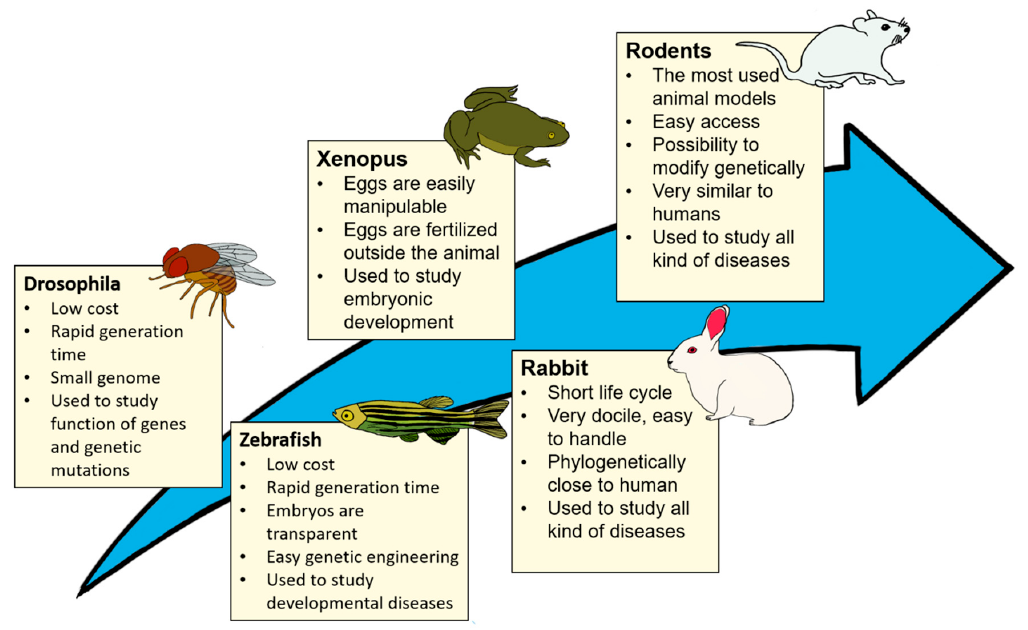
Figure 1. Advantages and applications of common animal models: drosophila [7], zebrafish [8], Xenopus [9], rabbit [10], or rodent [11] models in biomedical research.